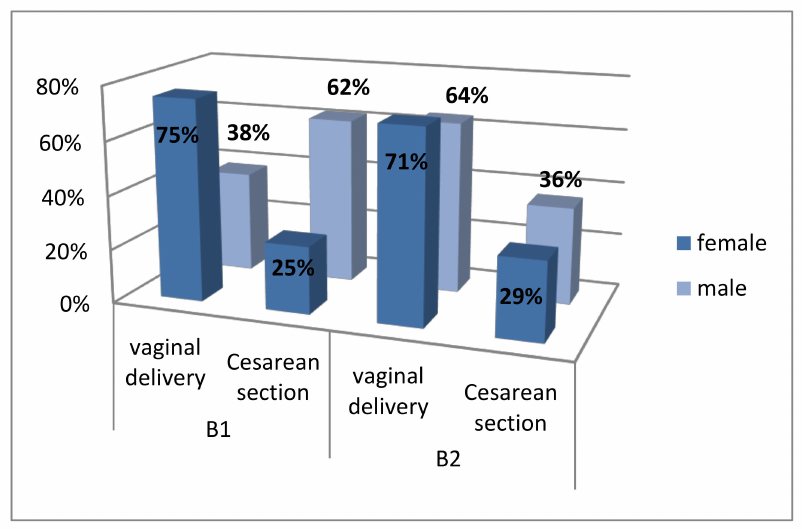
Figure 2. Distribution of vaginal deliveries and Cesarean sections between